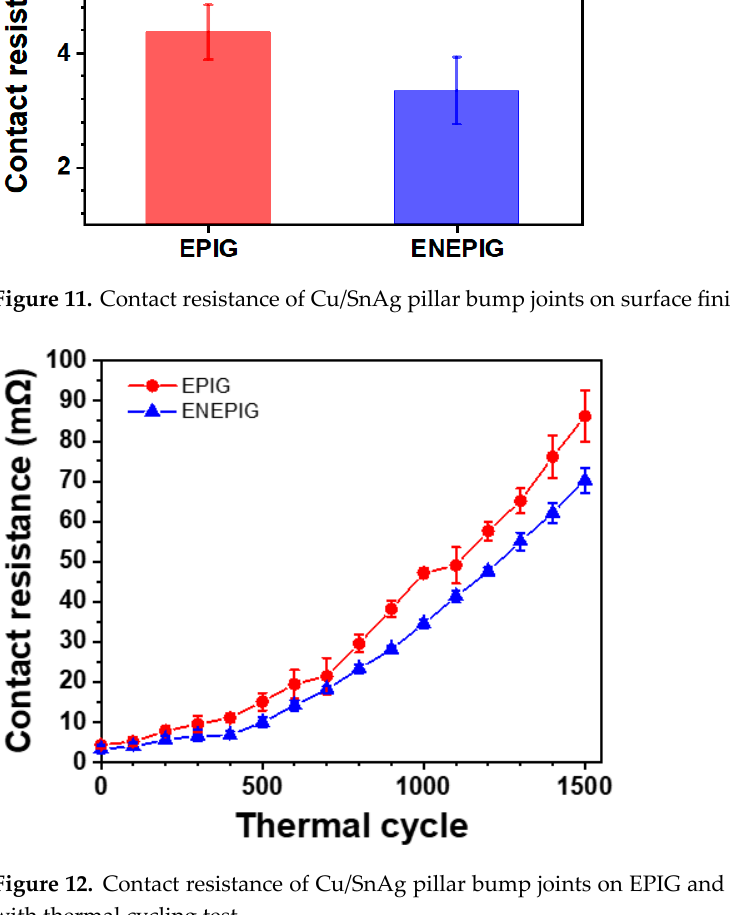
Figure 12. Contact resistance of Cu/SnAg pillar bump joints on EPIG and ENEPIG surface finishes with thermal cycling test.